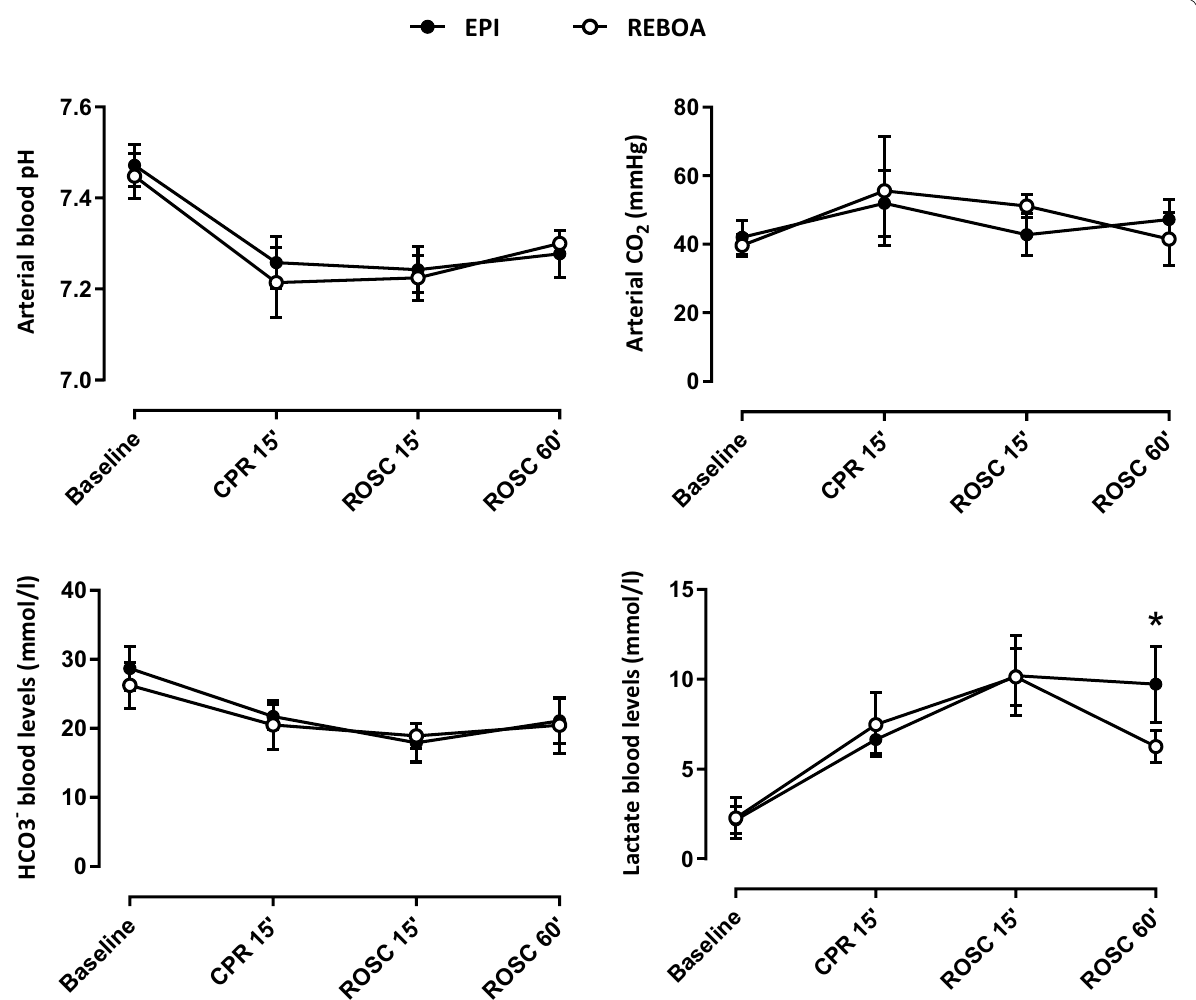
Fig. 3 Blood gases and lactates blood levels throughout experimental protocol. N CPR, cardiopulmonary resuscitation; ROSC, return of spontaneous circulation. Statistical comparisons were only made at each time-point between groups, but not between